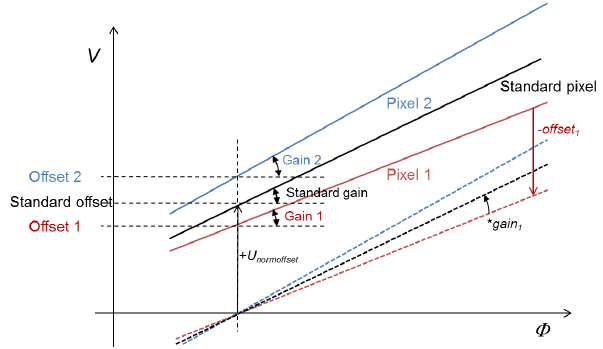
Figure 6. Schematic of the two-point correction procedure, using the example of two pixels. Dashed curves: the value “offset” is shifted parallel to the standard